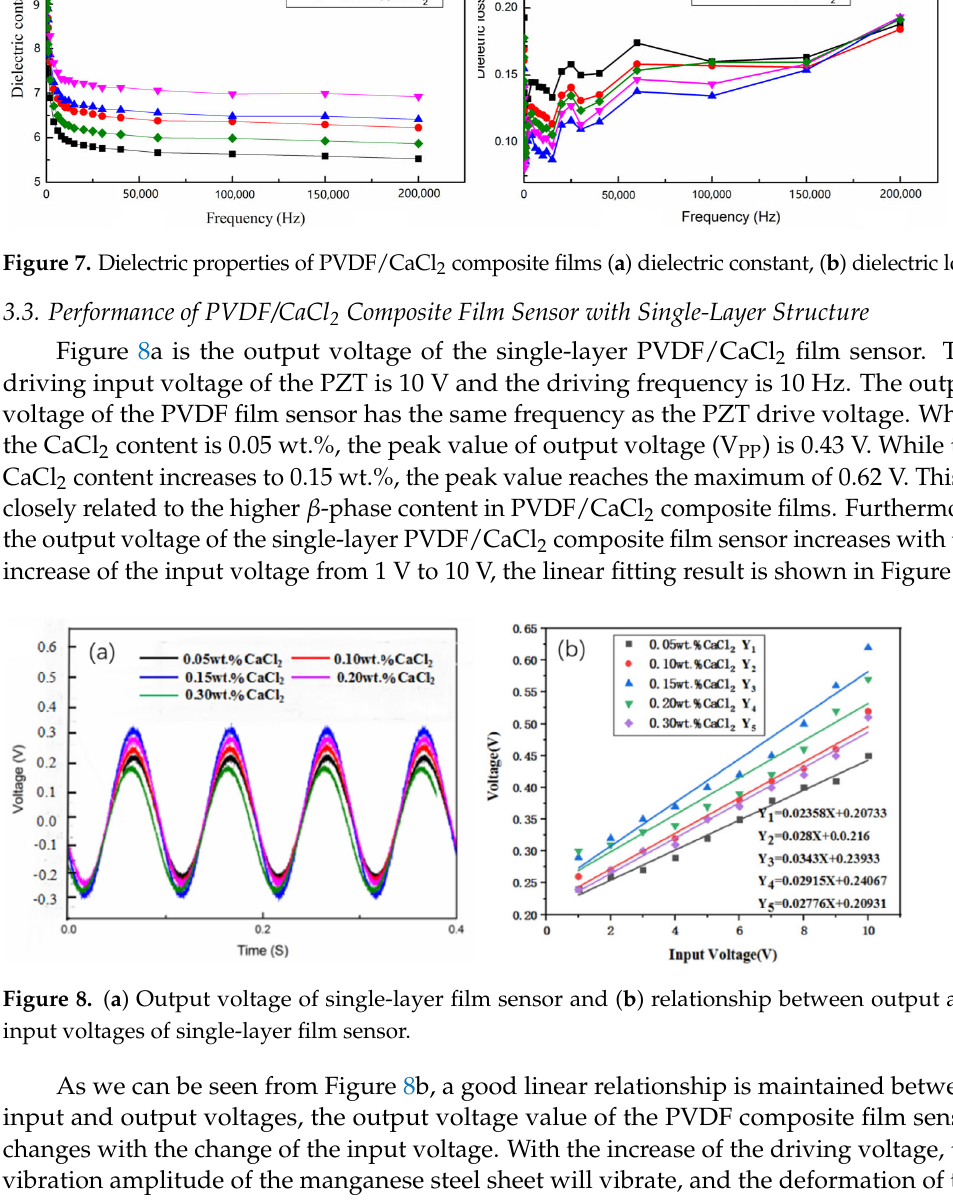
Figure 7. Dielectric properties of PVDF/CaCl 2 composite films ( a ) dielectric constant, ( b ) dielectric loss.